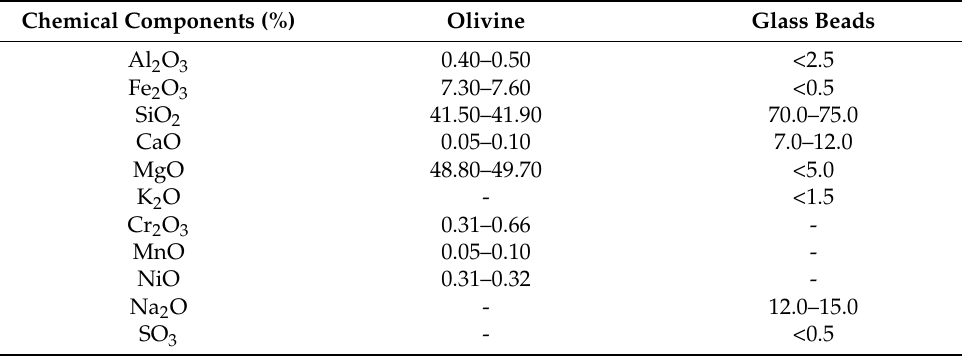
Table 4. Chemical composition (in%) of olivine and glass